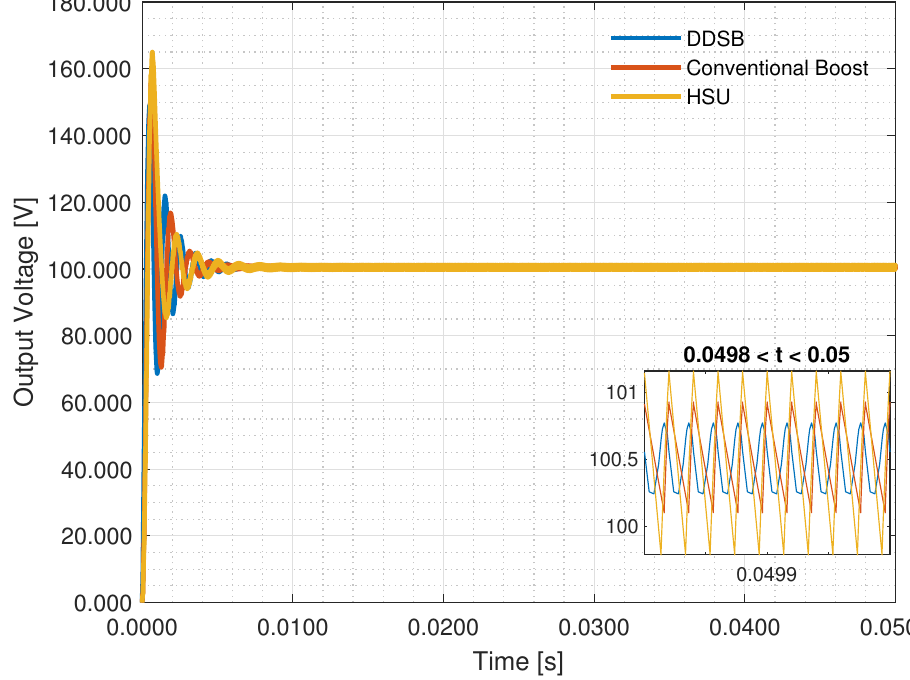
Figure 7. Comparison of the output voltage of the conventional boost ( d = 0.807), HSU ( d = 0.675), and DDSB ( d = 0.665) power